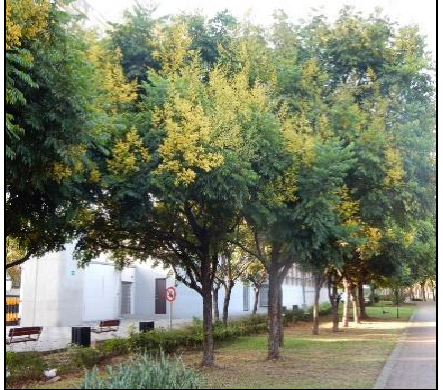
Figure 3. Picture of Koelreuteria henryi .